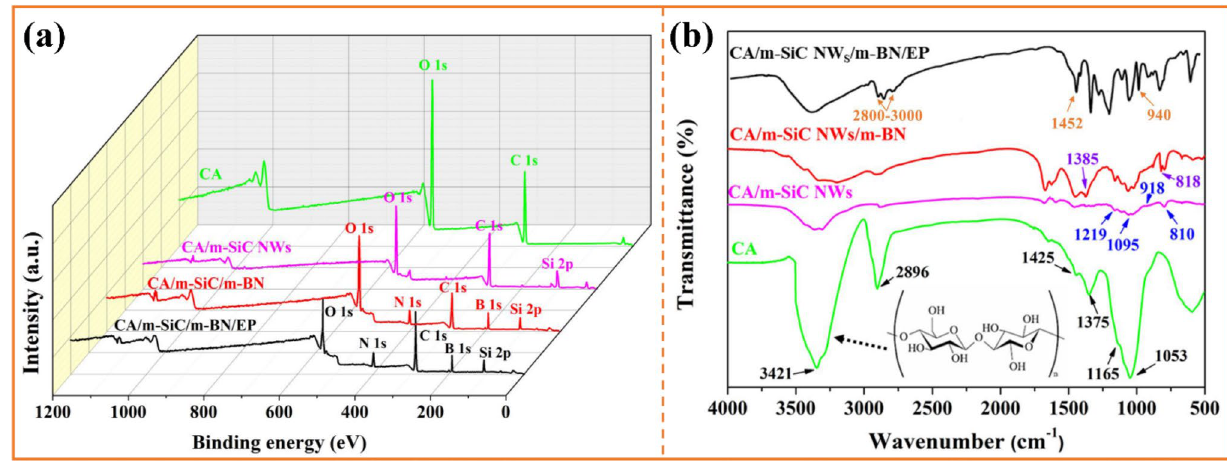
Fig. 4 a XPS and b FT‑IR spectra of CA, CA/m‑SiC NW S , CA/m‑SiC NW S /m‑BN and CA/m‑SiC NW S